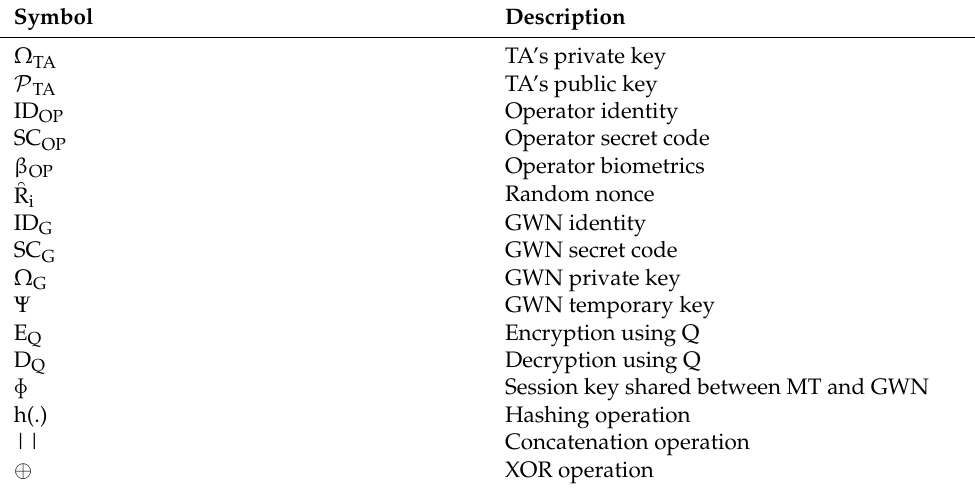
Table 1. Deployed symbols.